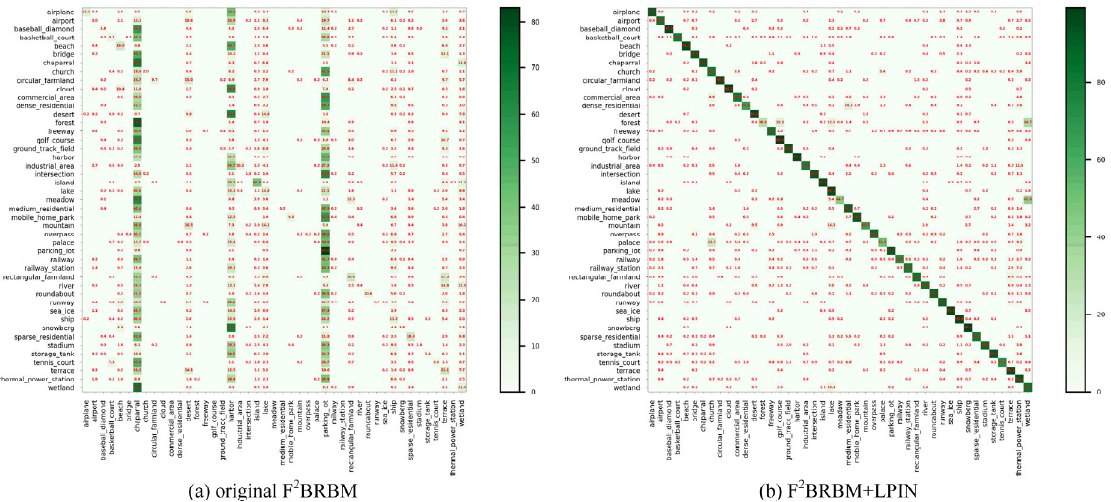
Figure 19. Confusion matrixes of the original F2BRBM ( a ) and F2BRBM + LPIN ( b ) on NWPU-RSISC45 with all three defects.